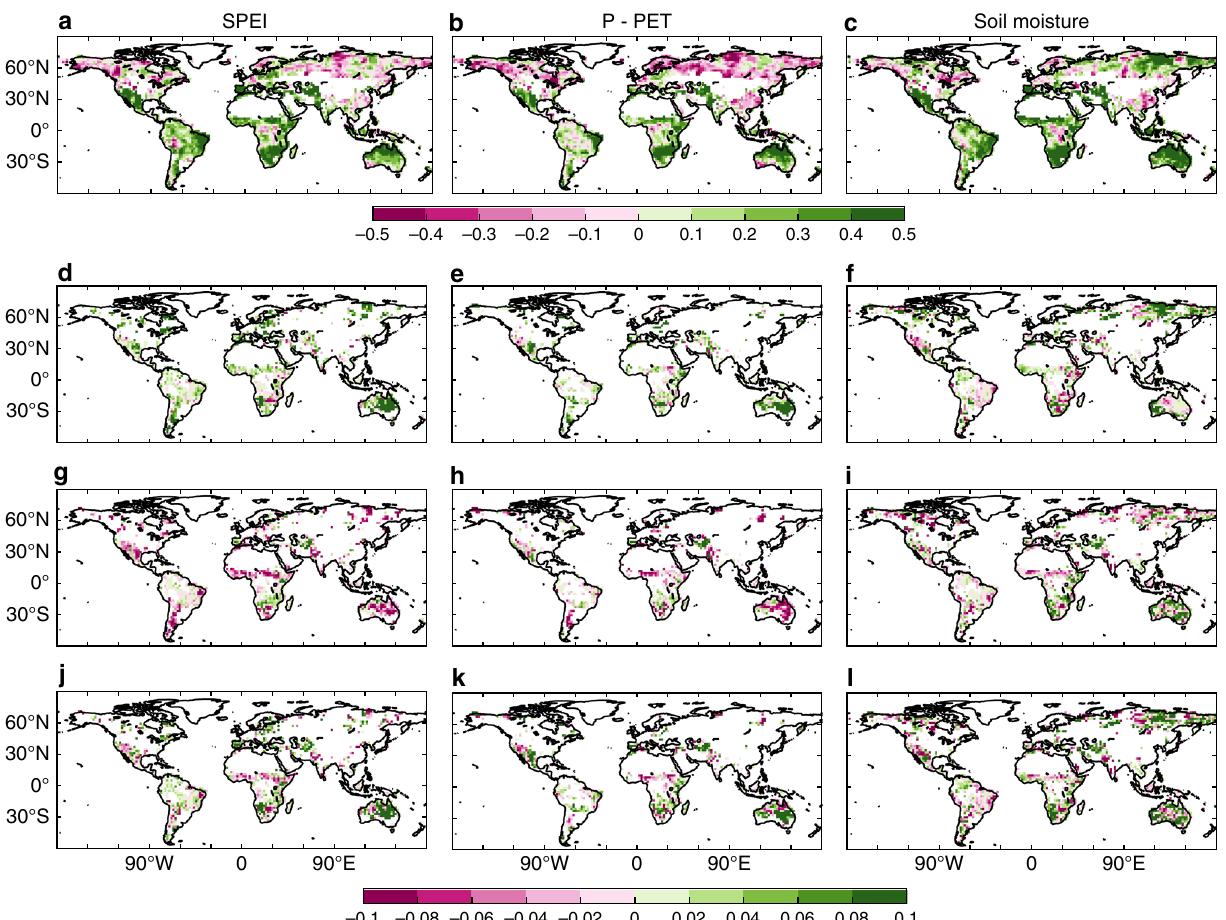
Fig. 3 Spatial distribution of NDVI change after extreme climate events. Spatial pattern of Pearson ’ s correlation coef fi cients between NDVI GS and the SPEI a , P − PET b , and soil moisture c . The change in greenness after extreme wetness, change in greenness after extreme drought and compensation for the SPEI d , g , j , P − PET e , h , k , and soil moisture f , i , l , where the NDVI GS values are signi fi cantly and positively correlated with the climate indices. The pixels with non-woody vegetation, not showing signi fi cant and positive correlation with climate indices except for a , b , c , or a multiyear mean NDVI value of < 0.1 were left blank. Maps were created using Matlab R2015b. P − PET: precipitation minus potential evapotranspiration, SPEI: Standardized Precipitation- Evapotranspiration